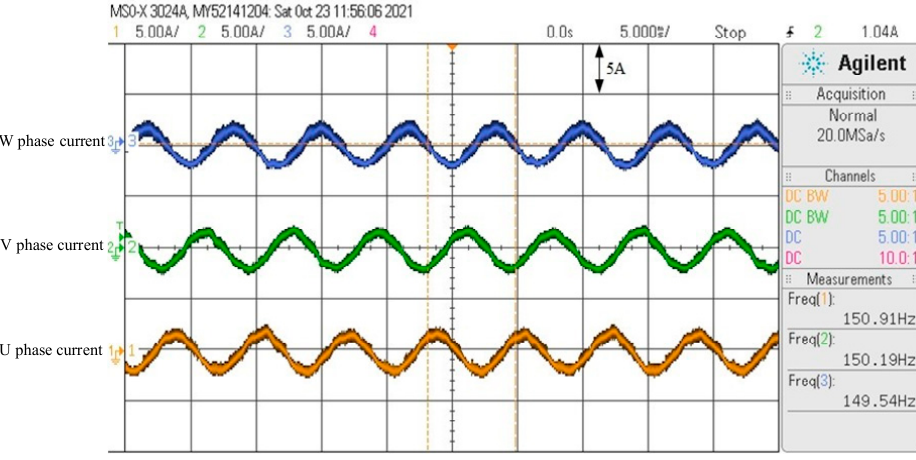
Figure 25. 3-phase output current waveform of the drive developed at rotational speed frequency command of 150 Hz.